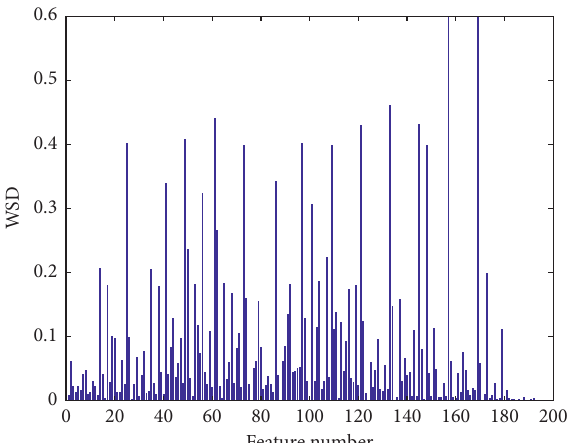
Figure 5: The WSD of 192 statistical features of the training